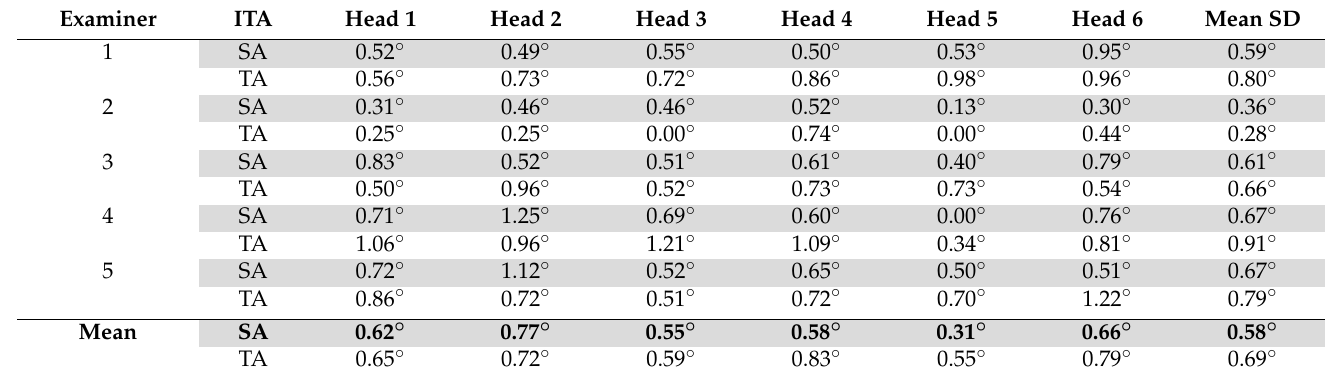
Table 2. Repeated SA and TA measures SDs ( α ◦ ) for individual examiner and head